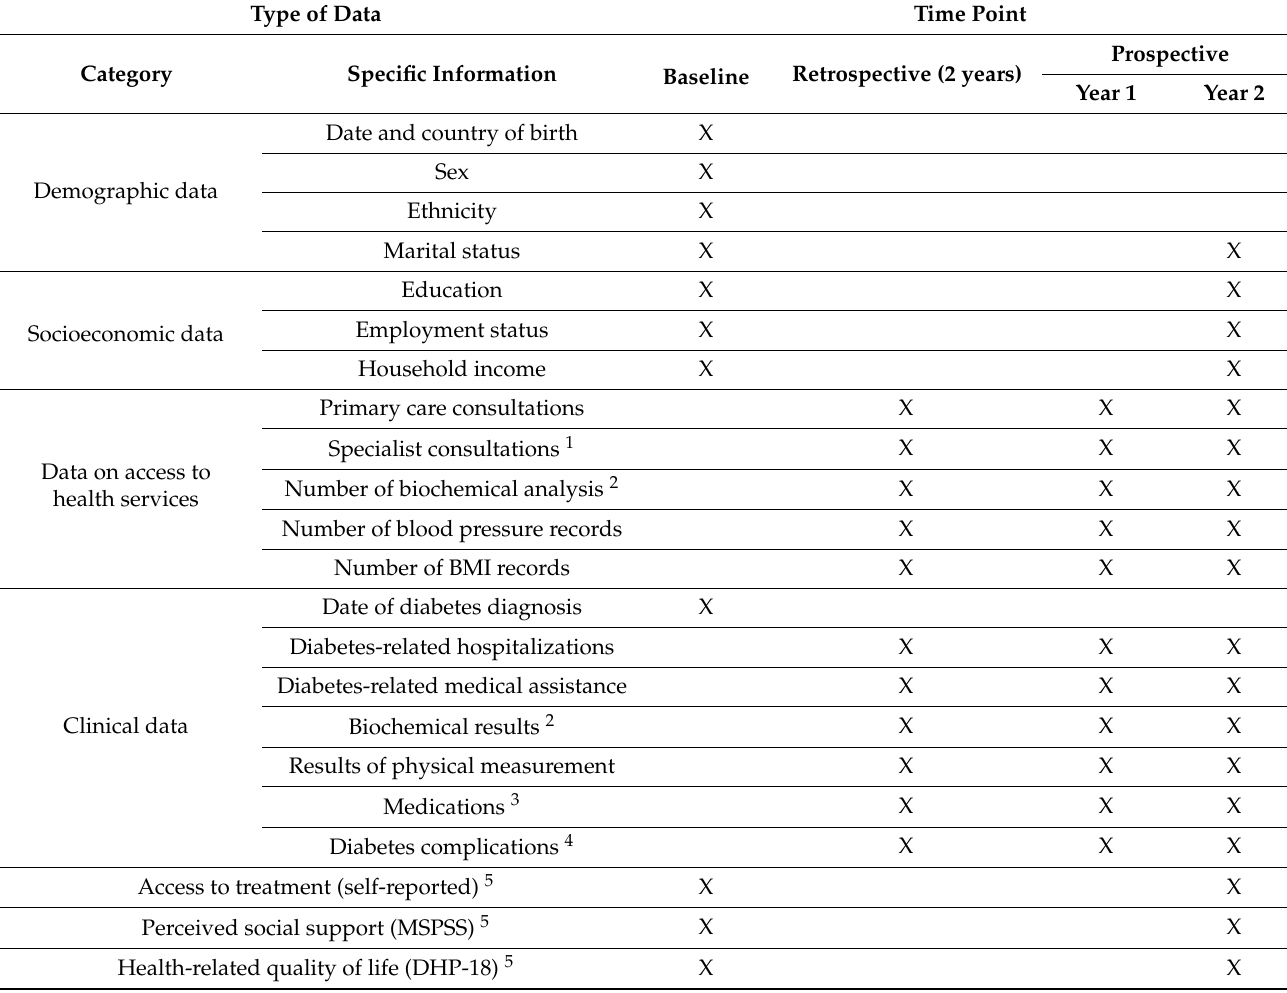
Table 1. Summary of routinely collected